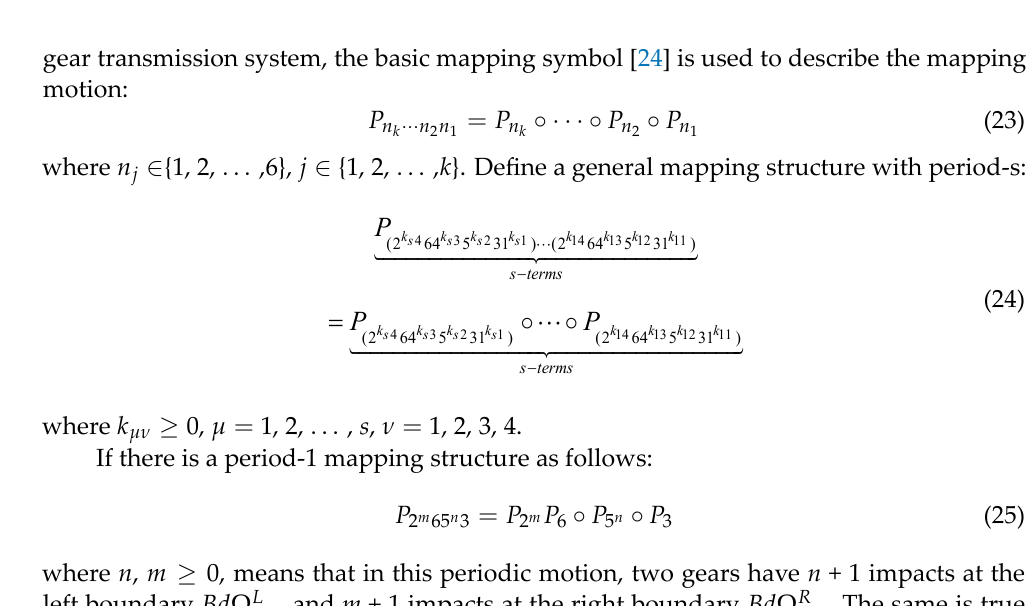
8 of 19 Figure 4. The mapping structures. To simplify the mapping structures of the system, impact is implied in the equation of motion. The impact motion is embedded into the mappings